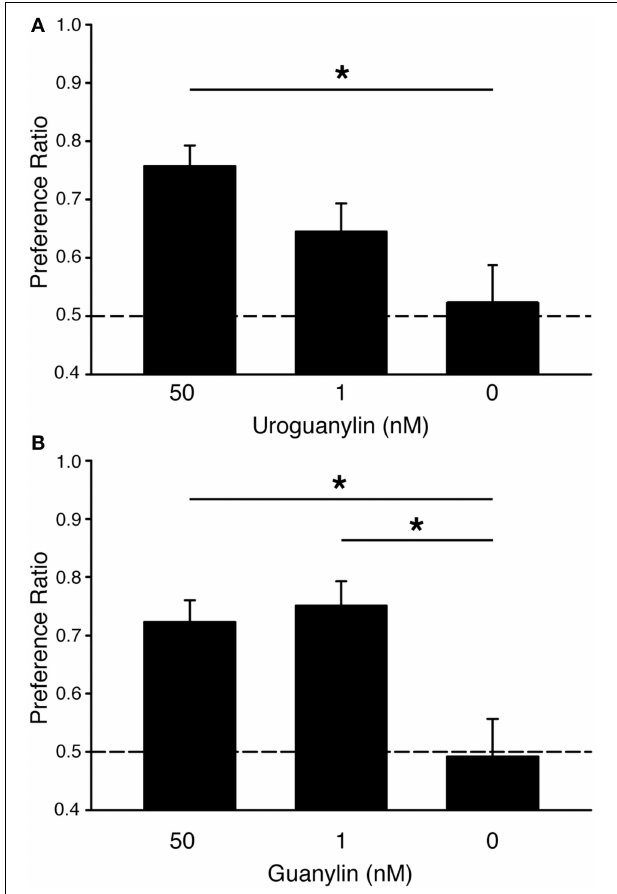
FIGURE 1 | Guanylin family peptides promote preferences for odored food adulterated with warfarin. (A) C57BL/6J mice acquired preferences for food containing a demonstrated odor when that odor was paired with 50nM uroguanylin (UG) even when both food choices had been adulterated with the rodenticide warfarin (0.025%). Mice were demonstrated a food odor paired with 50nM UG ( n = 8 ), 1nM UG ( n = 9 ), or 0nM UG ( n = 13 ). One-Way ANOVA [ F (1 , 29) = 4 . 31 , P < 0 . 05 ] followed by Tukeys post-hoc test ( * P < 0 . 05 ). (B) C57BL/6J mice acquired preferences for food containing a demonstrated odor when that odor was paired with either 50nM or 1nM guanylin even when both food choices had been adulterated with warfarin (0.025%). Mice were demonstrated a food odor paired with 50nM guanylin ( n = 7 ), 1nM guanylin ( n = 7 ), and 0nM guanylin ( n = 14 ). One-Way ANOVA [ F (1 , 26) = 6 . 29 , P < 0 . 01 ] followed by Tukeys post-hoc test ( * P < 0 . 05 ). Dashed lines, no preference. Error bars, standard error of the